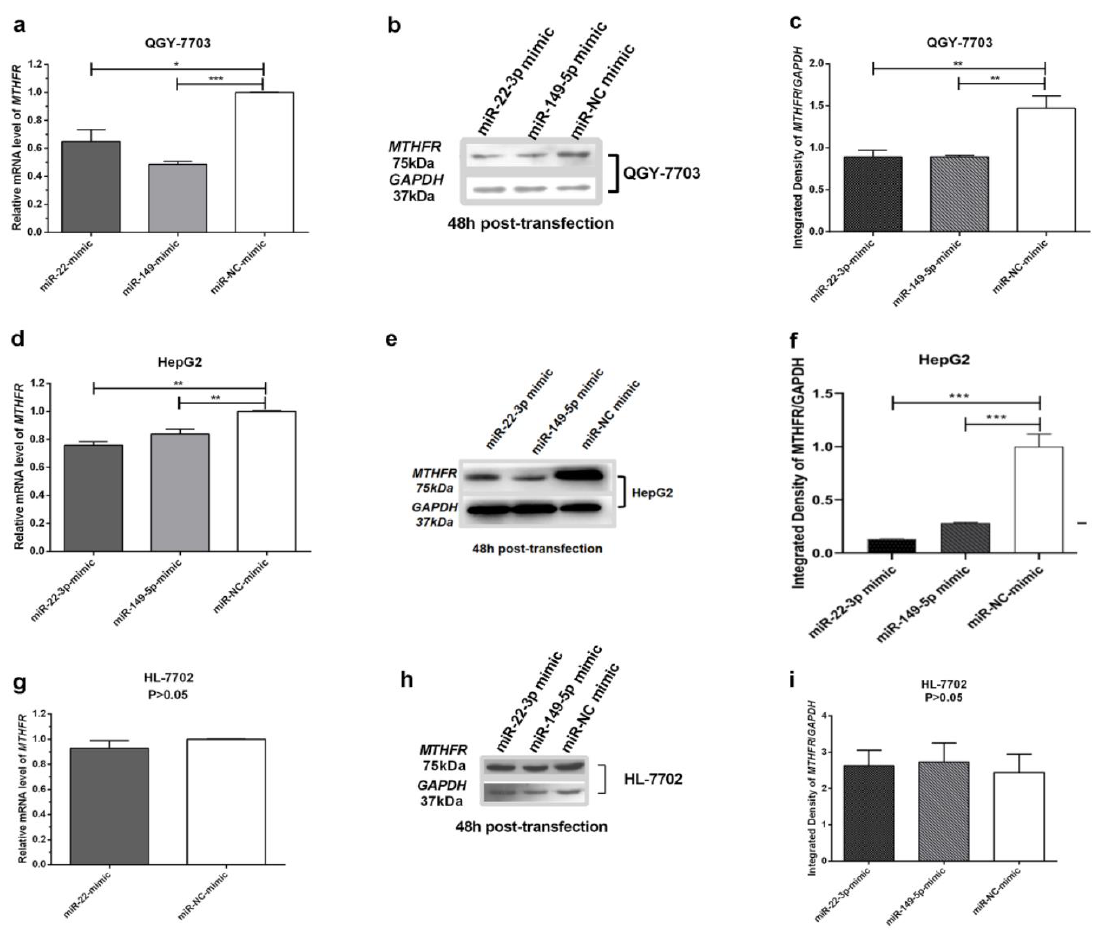
Figure 3. MTHFR mRNA expression and protein levels (after transfection for 48 h) in QGY-7703, HepG2, and HL-7702 cells after transfection with the miR-22-3p mimic (100 nM), miR-149-5p mimic (100 nM), and miR-NC mimic (100 nM); GAPDH served as an internal reference. ( a ) RT-qPCR assays revealed the mRNA expression of MTHFR in QGY-7703 cells after the transfection of miR-22-3p/miR-149-5p mimic; ( b ) Western blot assays showed the relative protein expression of MTHFR in QGY-7703 cells after transfection of miR-22-3p/miR-149-5p mimic; ( c ) densitometric analysis of protein bands in QGY-7703 cells after miR-22-3p/miR-149-5p mimic transfection; ( d ) RT-qPCR assays revealed the mRNA expression of MTHFR in HepG2 cells after miR-22-3p/miR-149-5p mimic transfection; (e) Western blot assays showed the relative protein expression of MTHFR in HepG2 cells after miR-22-3p/miR-149-5p mimic transfection; ( f ) densitometric analysis of protein bands in HepG2 cells after miR-22-3p/miR-149-5p mimic transfection; ( g ) RT-qPCR assays revealed the mRNA expression of MTHFR in HL-7702 cells after miR-22-3p mimic transfection; ( h ) Western blot assays showed the relative protein expression of MTHFR in HL-7702 cells after miR-22-3p/miR-149-5p mimic transfection. ( i ) Densitometric analysis of protein bands in HL-7702 cells after miR-22-3p/miR-149-5p mimic transfection; ( n = 3; * p < 0.05, ** p < 0.01, *** p < 0.001).